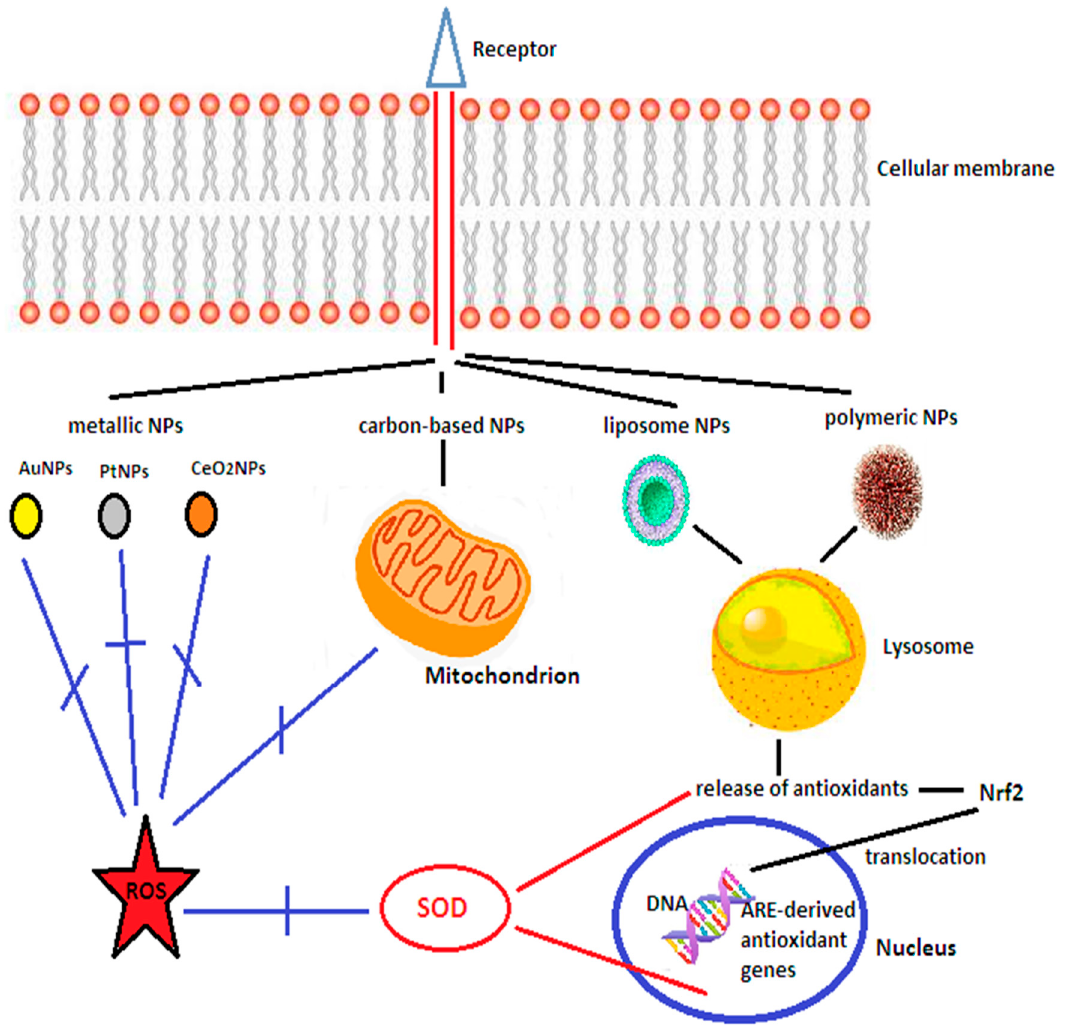
Figure 3. Schematic presentation of the action of the main categories of nanomaterials. Nanoparticles enter the cell through receptor-mediated endocytosis. Metallic nanoparticles (AuNPs, PtNPs, and cerium oxide NPs or nanoceria) have free radical scavenging properties. PtNPs also mimic SOD and CAT activity. Nanoceria downregulate iNOS and reduce the amount of nitric oxide and peroxynitrite. Carbon-based nanomaterials have SOD-like activity and protect the mitochondria from free radical damage. Liposome and polymeric nanoparticles can carry antioxidant molecules, enzymes, and genes which can activate Nrf2 and promote its nuclear translocation, where it binds to antioxidant response element (ARE) leading to the expression of ARE-derived antioxidant genes. NPs—nanoparticles; AuNPs—gold nanoparticles; PtNPs—platinum nanoparticles; CeO ₂ NPs—nanoceria; Nrf2—nuclear factor-erythroid 2-related factor 2; SOD—superoxide dismutase; DNA—deoxyribonucleic acid; ROS—reactive oxygen species; ARE—antioxidant response element; Blue lines indicate inhibitory activity, while red lines indicate activation. Adapted from Song et al. [216].